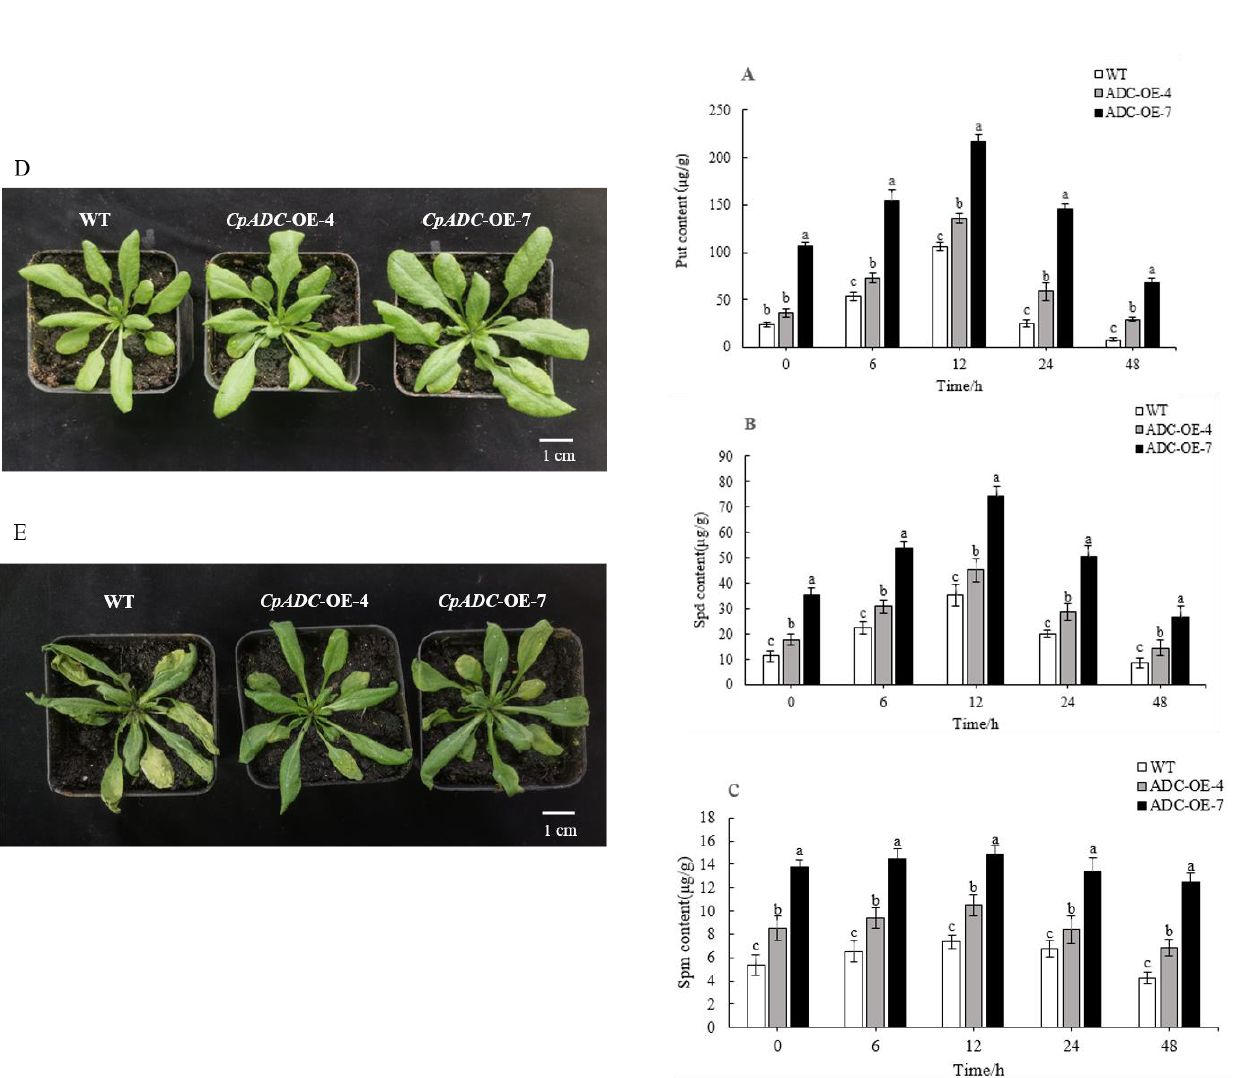
Figure 3. PAs content in 30 d leves of WT, CpADC-OE-4 and CpADC-OE-7. ( A ) Free putrescine content. ( B ) Free spermidine content. ( C ) Free spermine content. Values are means of three biological replicates. Note: Different lowercase letters are used to indicate means that differ significantly ( p ≤ 0.05); ( D , E ) Arabidopsis lines before and after drought treatment, respectively.